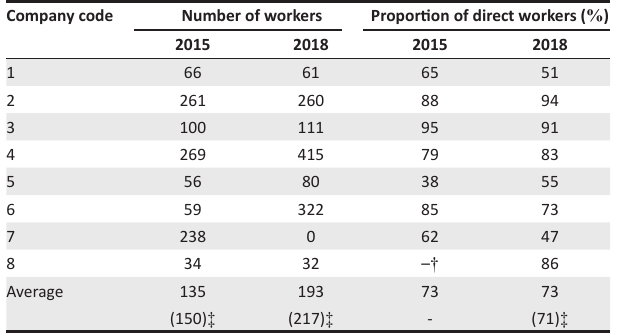
TABLE 2: Number of workers and proportion of direct workers before (2015) and after (2018) Kaizen training. Company code Number of workers Proportion of direct workers ( %